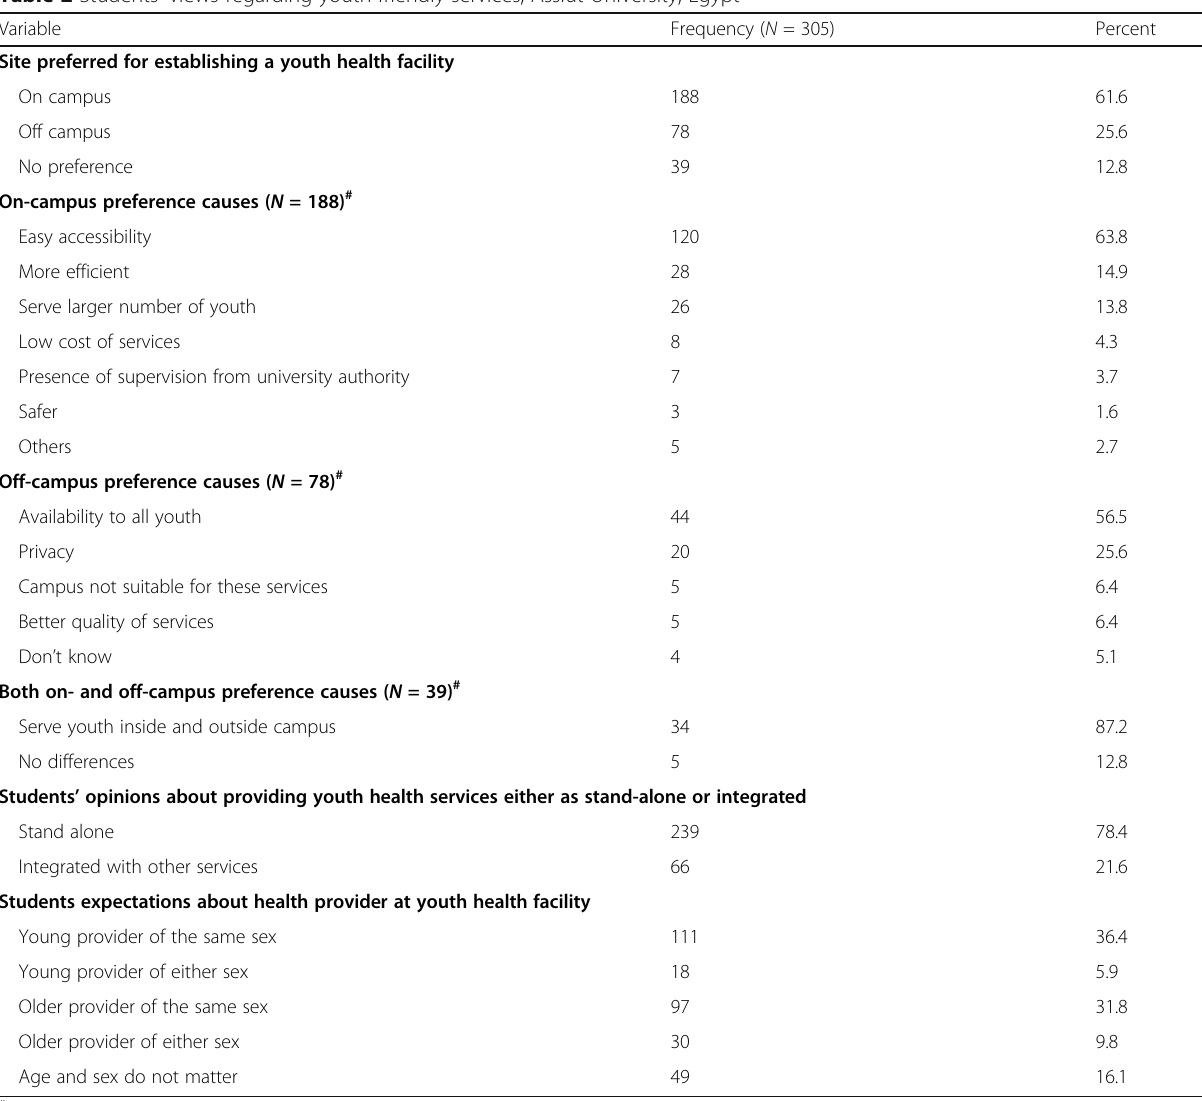
Table 2 Students ’ views regarding youth-friendly services, Assiut University,